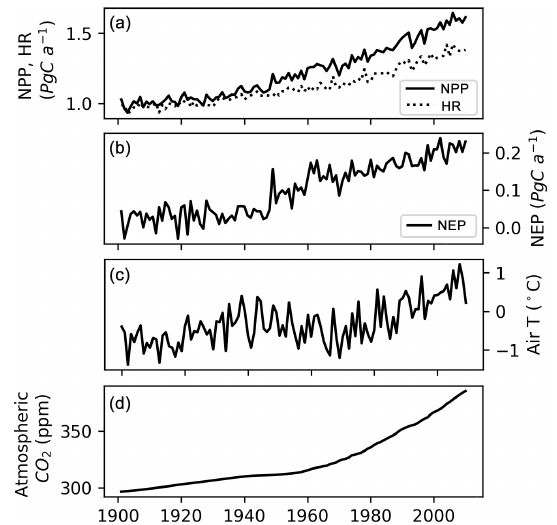
Figure 12. (a) Simulated annual net primary production (NPP), heterotrophic respiration (HR) of northern peatlands, (b) simulated net ecosystem production (NEP) of northern peatlands, (c) mean air temperature ( T ) of grid cells that have peatland, and (d) atmo- spheric CO 2